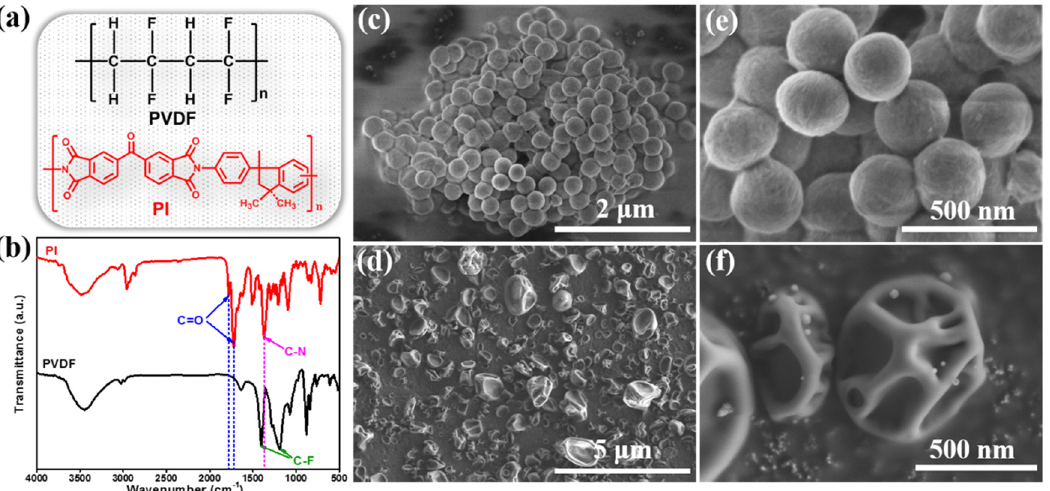
Figure 1: ( a ) Chain structures and ( b ) FT - IR spectra of PVDF and PI binders; SEM images of ( c and e ) PVDF and ( d and f ) PI